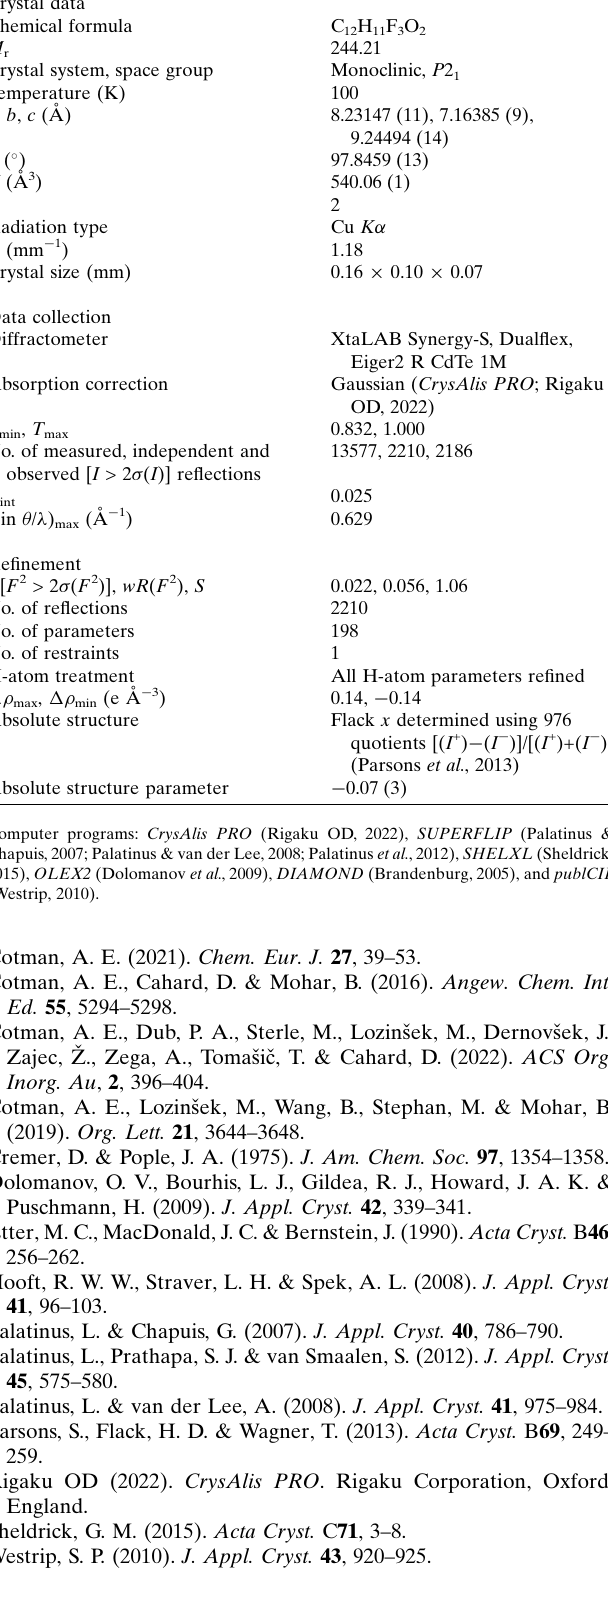
Table 2 Experimental details. Crystal data Chemical formula